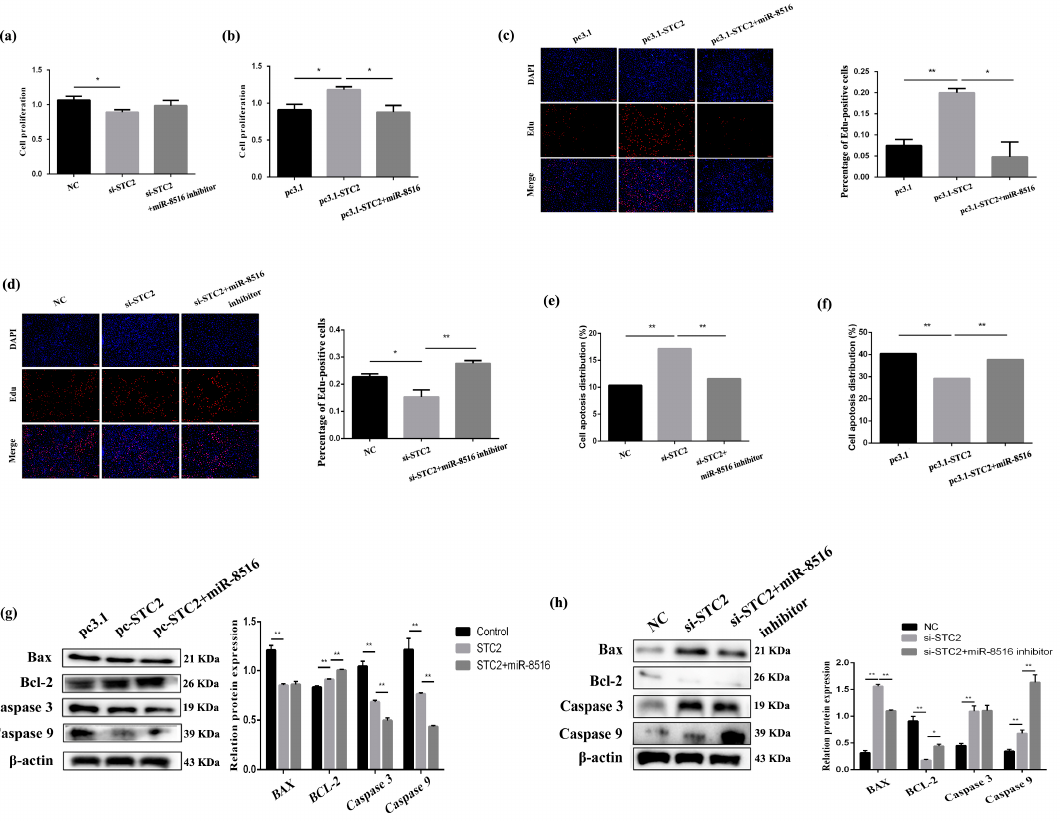
Figure 4. STC2 inhibited apoptosis and promoted proliferation of GMEC in vitro. ( a , b ) Cell proliferation was assessed using the cell counting kit-8 (CCK-8) assay after transfection with pc3.1-STC2 or si-STC2. ( c , d ) Cell proliferation indices were assessed after treatment with Edu after transfection with pc3.1-STC2 or si-STC2. ( e , f ) Apoptosis analysis of GMEC was detected with flow cytometry method after transfection with pc3.1-STC2 or si-STC2. ( g , h ) Protein levels of Bcl-2, Bax, caspase 3 and caspase 9 in GMEC after transfection with pc3.1-STC2 or si-STC2. Protein levels were measured by WB (western blot) densitometry was normalised to the β -actin density from the same lane. Data were expressed as the means ± SEM. ** p < 0.01, * p <